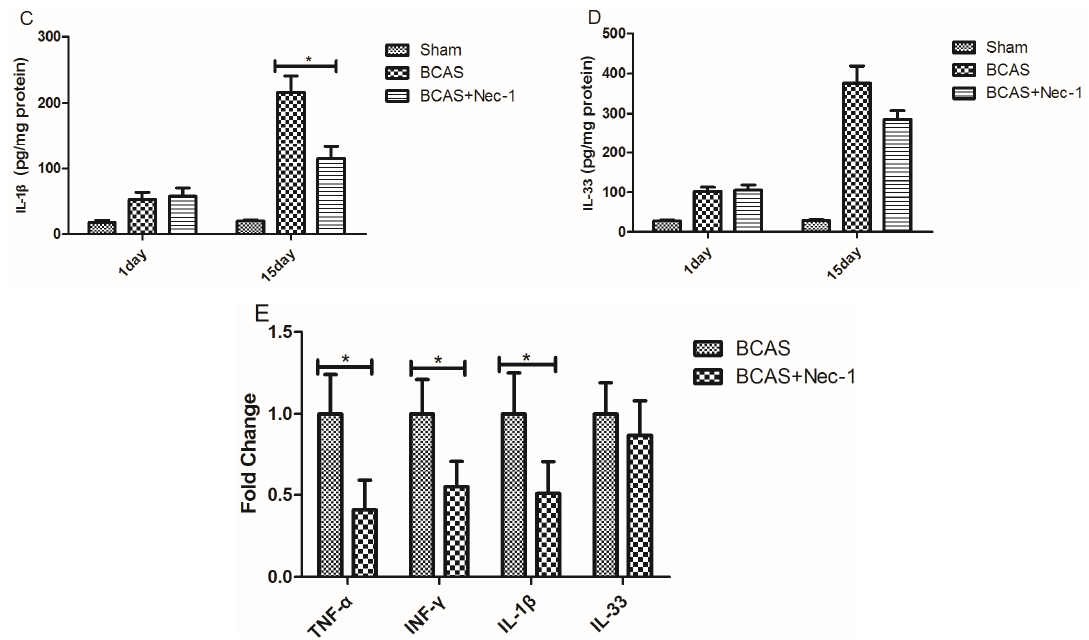
Figure 7. Inflammatory cytokines expression was decreased in the mice treated with Nec-1. Data showed that the protein concentrations of TNF- α ( A ), IFN- γ ( B ), IL-1 β ( C ) and IL-33 ( D ) in brain tissues at the 15th day after BCAS surgery as measured by ELISA and that mRNA levels of these cytokines had the same change ( E ) (* p < 0.05).